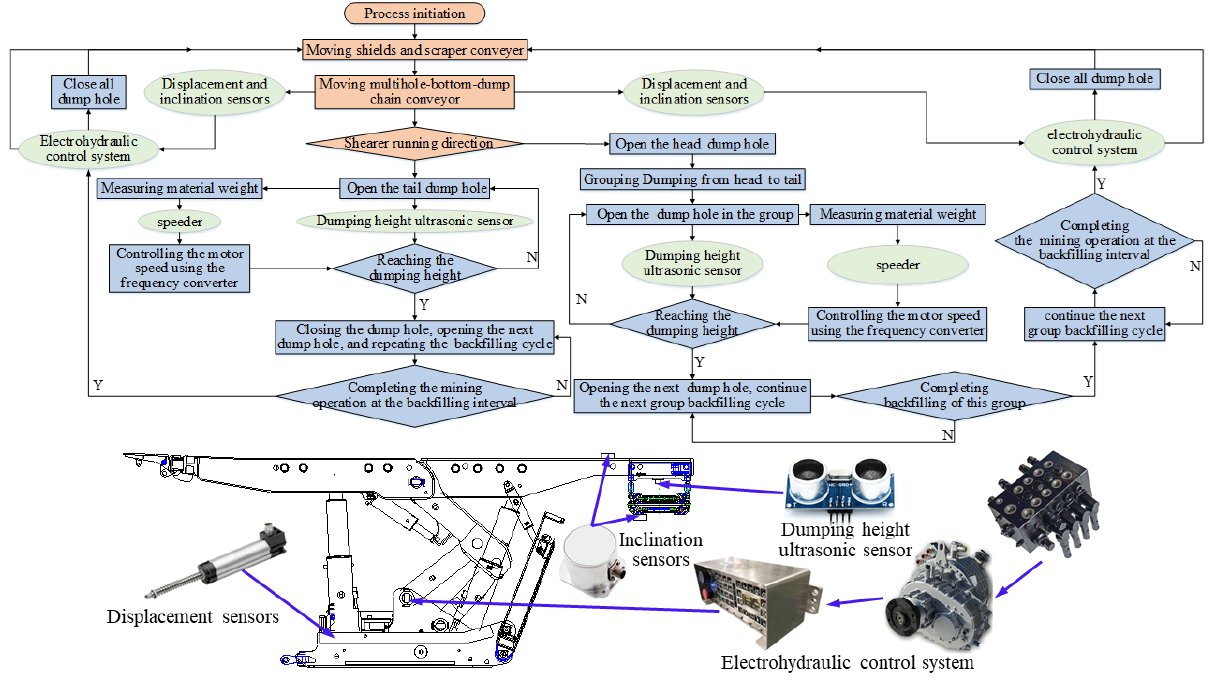
Figure 8. Schematic diagram of an automated control system for backfilling.